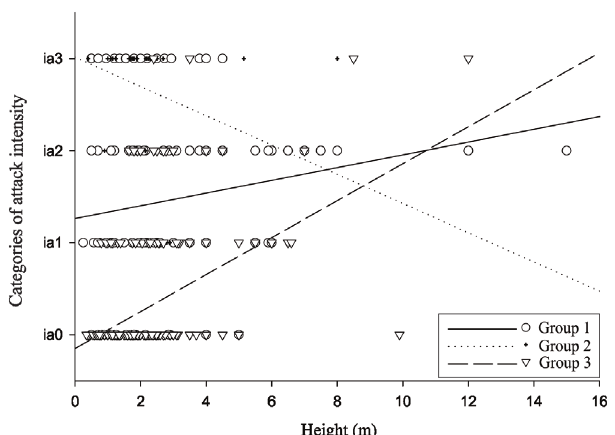
Fig 4. Effect of the size of plant species on the intensity of attack by termites in the Cerrado of the Estação Ecológica de Pirapitinga. The adjusted minimum model presents three distinct groups based on intensity of termite attack: Group 1 – continuous line ( Annona sp., Pterodon emarginatus , Qualea grandiflora and Qualea multiflora ); Group 2 dotted line ( Bauhinia brevipes ); and Group 3 hatched line ( Xylopia aromatic , Miconia albicans, Siparuna guianensis and Coussarea